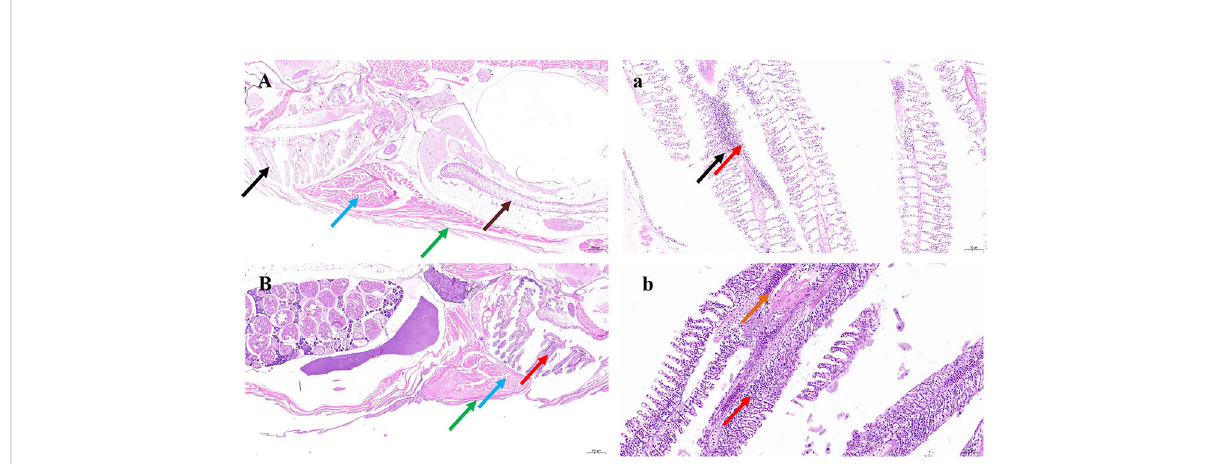
FIGURE 7 Pathological tissue section results. Tissue sections of Danio rerio fi ngerlings experimentally infected with MEDF7. (A-a) : Necrosis foci are occasionally seen in the gill, with some gill fi lament necrosis, cell nuclei fragmentation or dissolution (black arrow), accompanied by in fl ammatory cell dot in fi ltration (red arrow); Intestinal epithelial exfoliation and lamina propria exposure (brown arrow); Note the regular arrangement of muscle fi bers (blue arrow); There are more mucus cells in the skin (green arrow),H&E, X =2.0-20.0. (B-b) : The gill fi laments are short and thick with extravasation (orange arrows) and more in fl ammatory cells (red arrows). Loose .